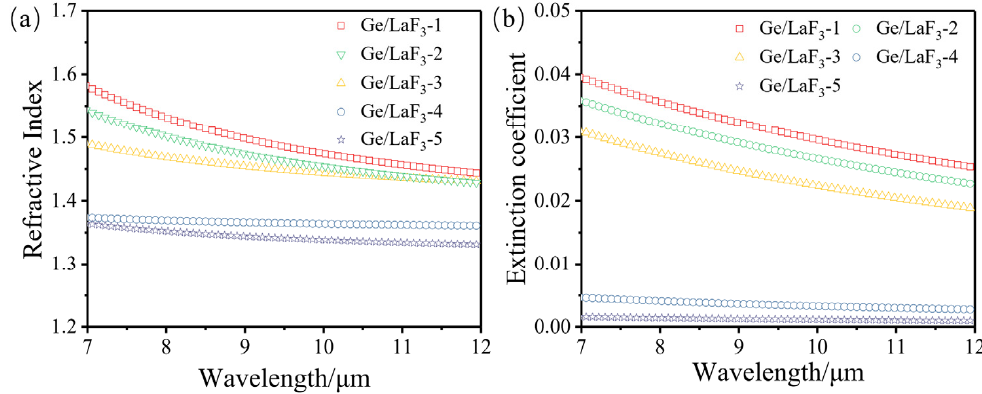
Figure 5. ( a ) Refractive index curves and ( b ) Extinction coefficient curves of LaF 3 films on Ge substrate with different oxygen contents.